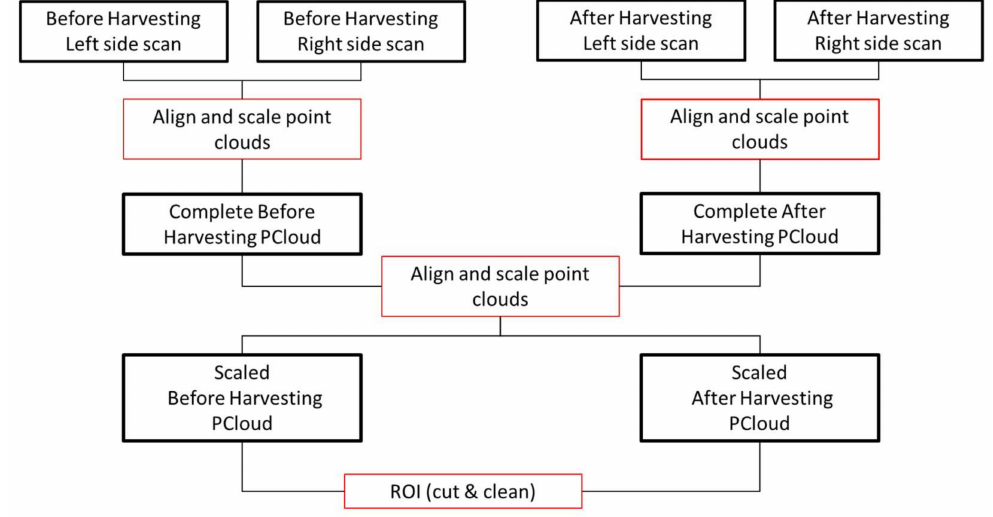
Figure 3. The workflow scheme for point cloud alignment and filtering for each LiDAR